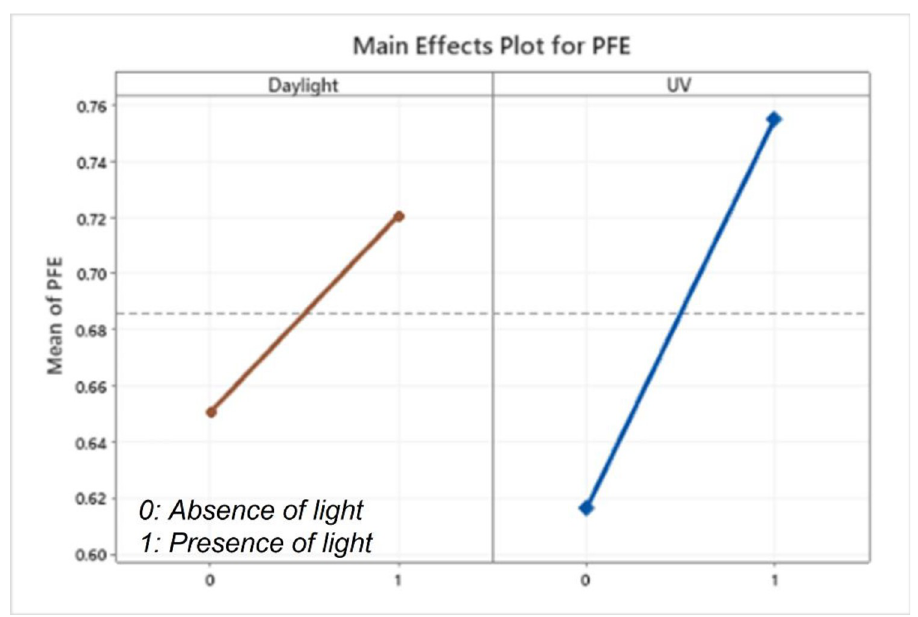
Fig 6. Photocatalytic activation of nanoparticles enhances PFE by ~7% in daylight and ~13% in UV light.